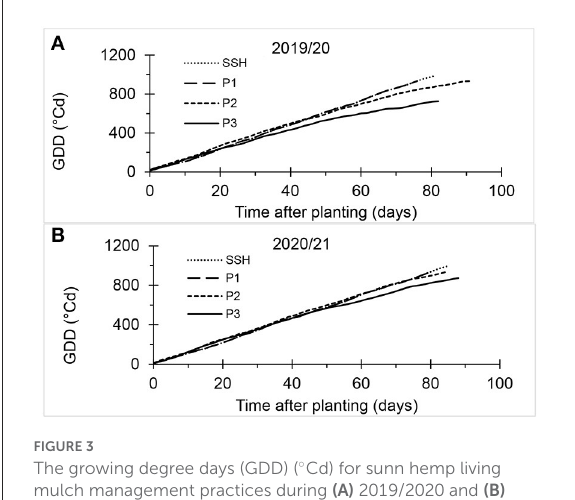
FIGURE3 The growing degree days (GDD) ( ◦ Cd) for sunn hemp living mulch management practices during (A) 2019/2020 and (B) 2020/2021 growing seasons (SSH, sole sunn hemp; P1, simultaneous sunn hemp and maize planting; P2, sunn hemp planted at the V15 maize growth stage; P3, sunn hemp planted at R1 maize growth stage).